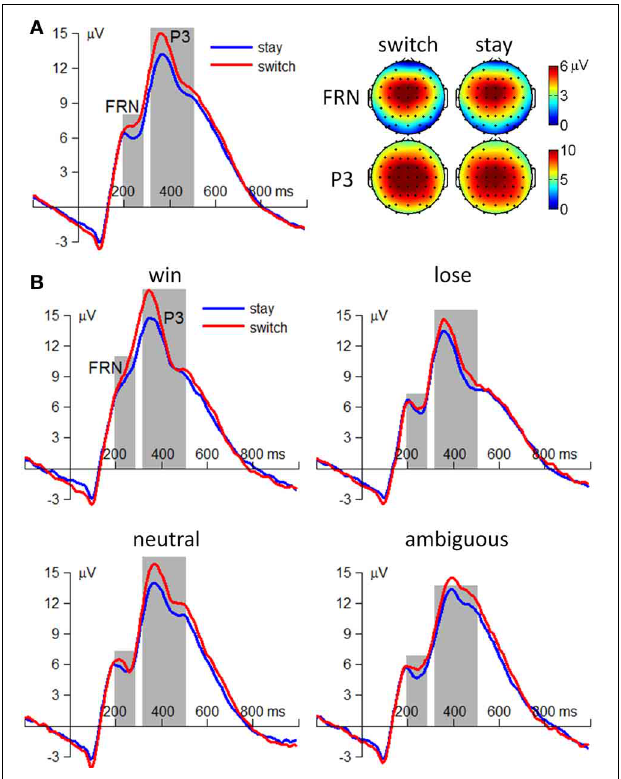
FIGURE 3 | ERP results from 39 participants. (A) The main effect of subsequent strategy. Left: grand-mean ERP waveforms at electrode site Cz. Right: scalp topographies averaged from 200 to 280ms for the FRN and from 320 to 500ms for the P3. (B) The interaction effect of outcome valence by subsequent strategy. The t = 0ms indicated the onset of outcome